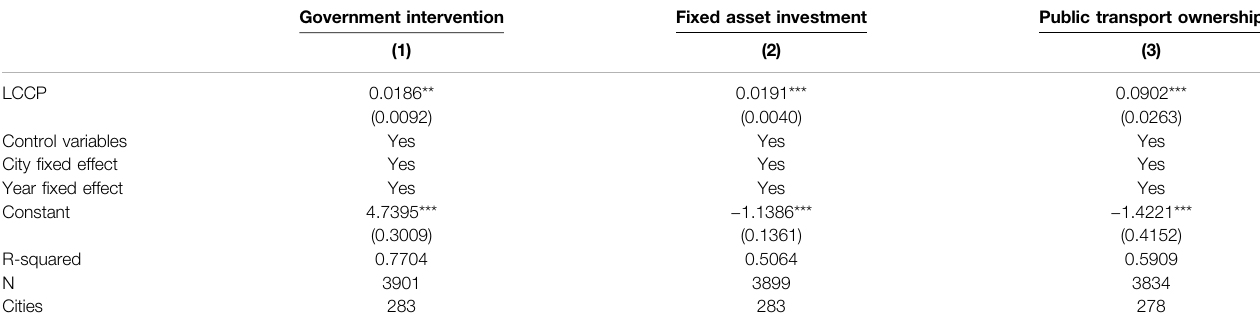
TABLE 3 | LCCP and Government behaviors.